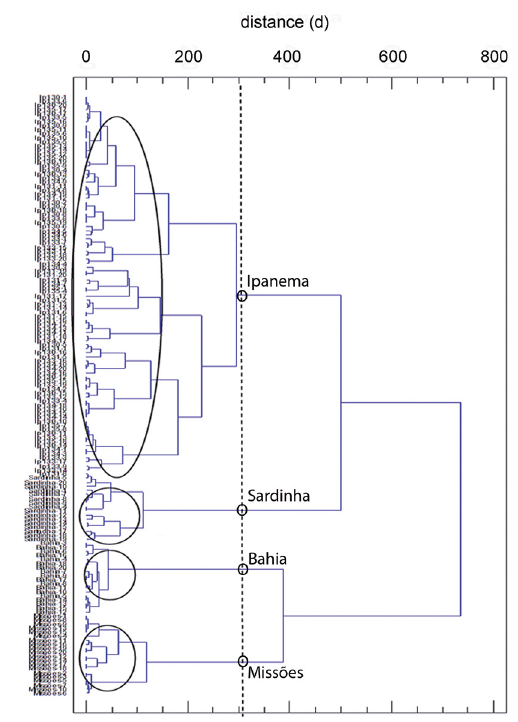
Figure 4: Dendrogram using the treated EDX results of the entire multiphase slag inclusions.